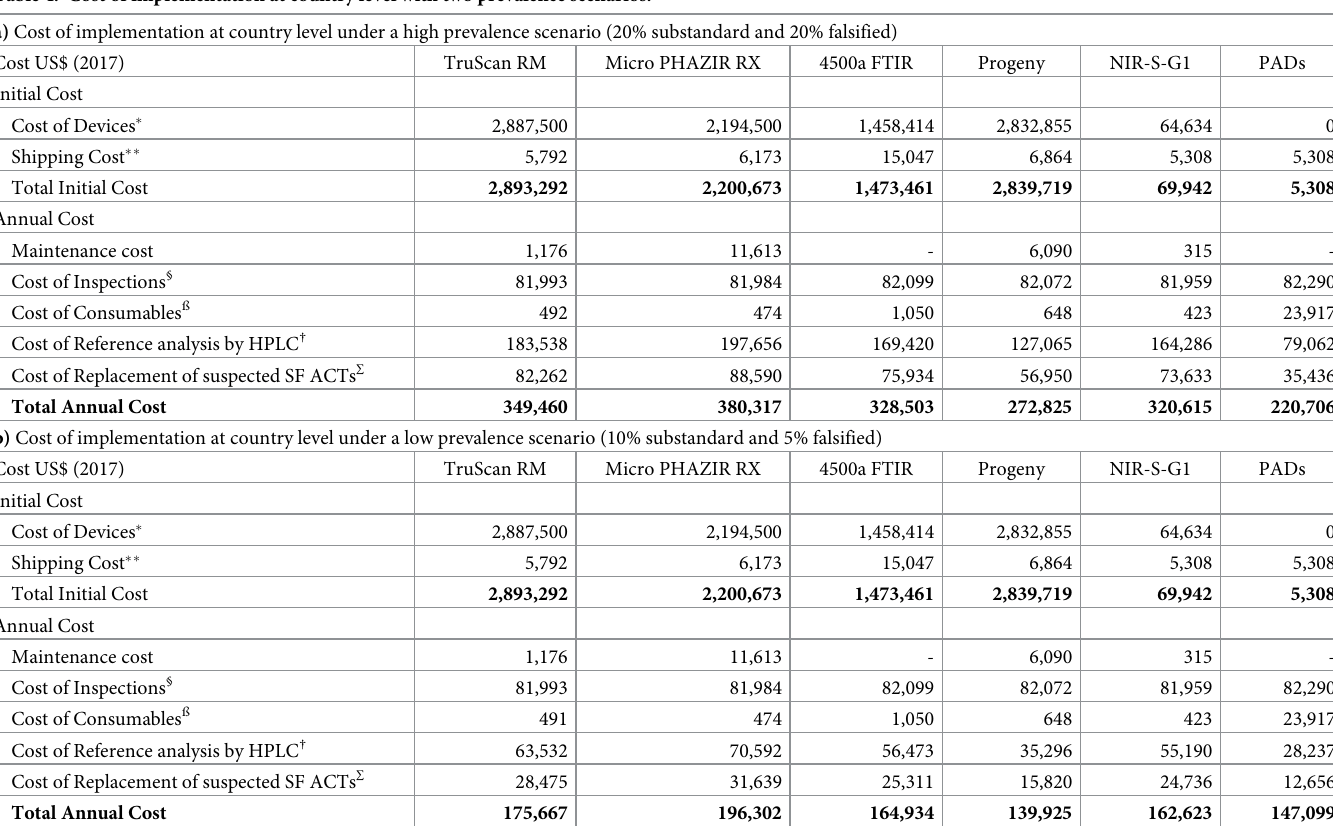
Table 4. Cost of implementation at country level with two prevalence